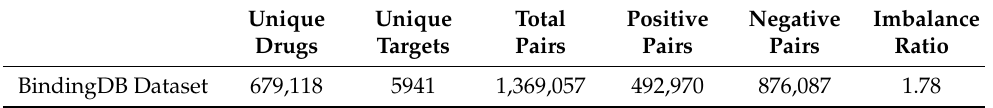
Table 1. Dataset description and statistical information. Unique